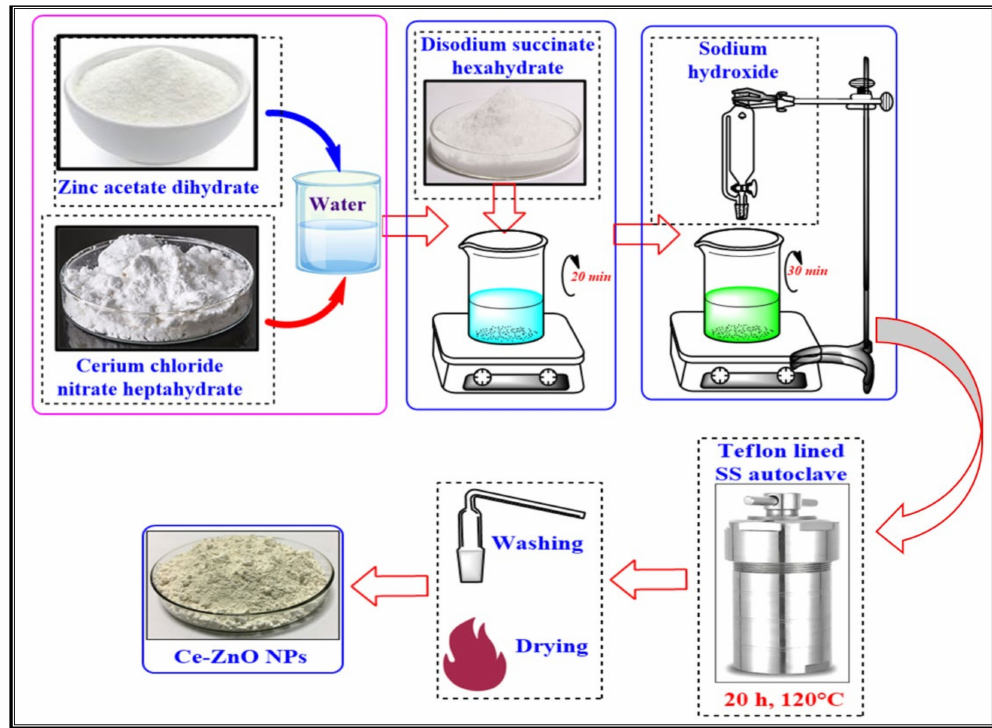
Figure 3. Synthesis of Ce doped ZnO